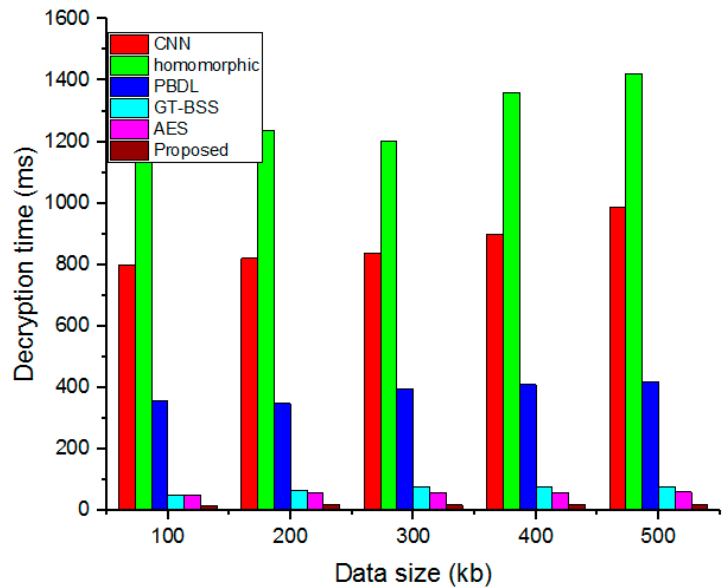
Figure 6. Analysis of di ff erences in Decryption time.